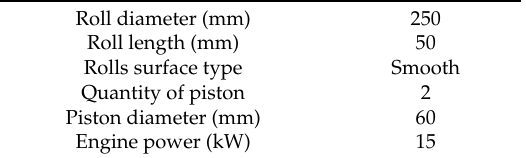
Table 1. Device features and test conditions used in this work.